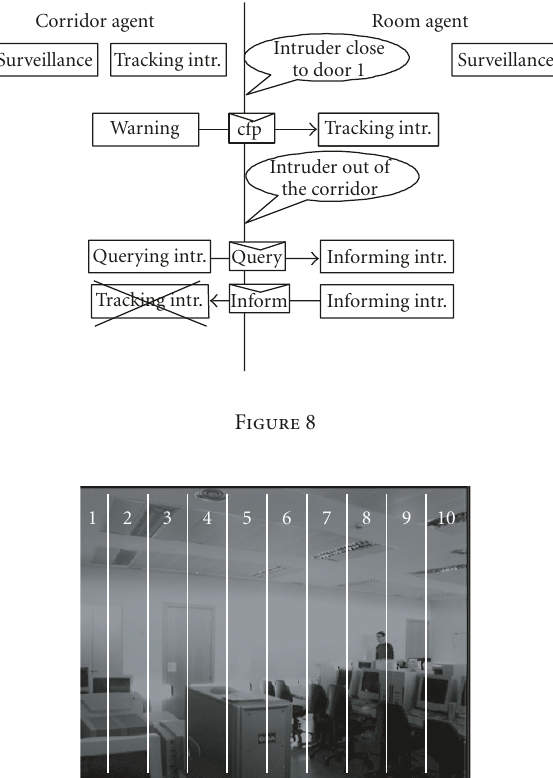
Figure 9: Segmentation of each frame into ten zones for better mea- surement